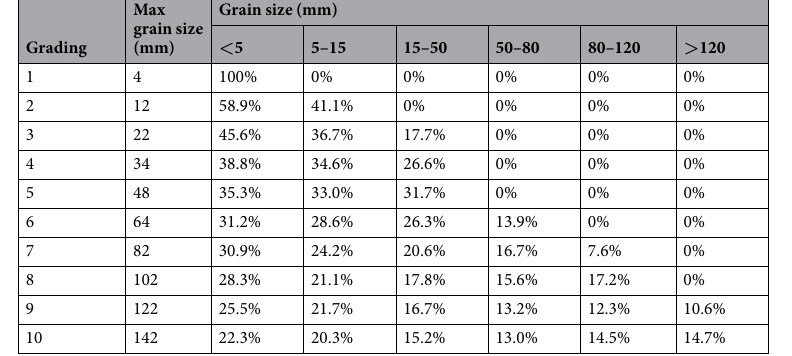
Table 1. Test soil grades and